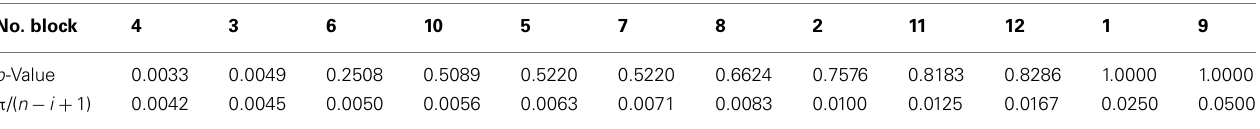
TableA3 | Numbers of choices of LL along the 12 test blocks (data shown in Figure 2C) were analyzed by multiple comparisons after sequential Bonferroni corrections (Hommel, 1988).